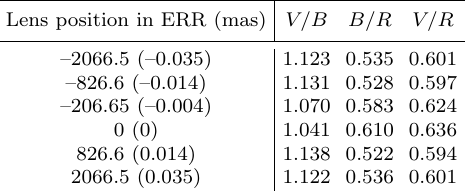
Fig. 2. Changes in spectral energy distributions of the source with the stratified emitting regions (see the text) modeled for six different positions of microlens shown in Figure 1. Table 1. Emission ratios in the V , B and R photometric passbands for a lens consisting of 10 stars randomly distributed in a compact group. The lens position is given both in ERR (Einstein Ring Radius) and in milliarcseconds (in